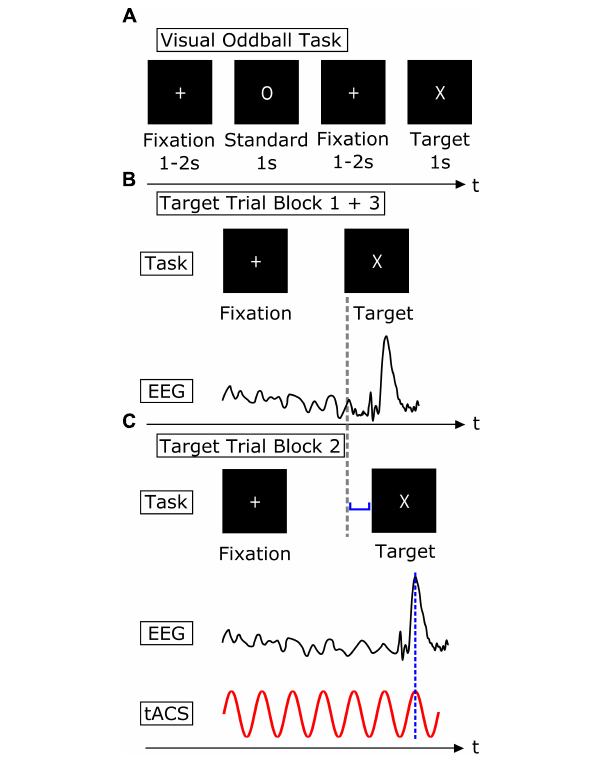
FIGURE 2 | Timing of visual and electrical stimulation. (A) Visual Oddball Task. The task consisted of two different visual stimuli, a standard stimulus (“O”) and a target stimulus (“X”). Subjects were instructed to press a button whenever a target stimulus appeared on the screen and refrain from pressing the button whenever a standard stimulus was shown. Stimuli were presented for 1000 ms. Stimulus presentation was interrupted by an inter-stimulus interval which was randomly varied between 1000 and 2000 ms. (B) Schematic procedure of a single target trial in experimental block 1 and 3. Visual presentation of the target stimulus (upper row) and EEG with P300 component following the target stimulus (lower row). (C) Schematic procedure of a single target trial in experimental block 2. Target stimulus onset is adjusted (blue bracket) in order to ensure an overlap of the P300 peak and a peak of the sinusoidal tACS, indicated by the dashed blue